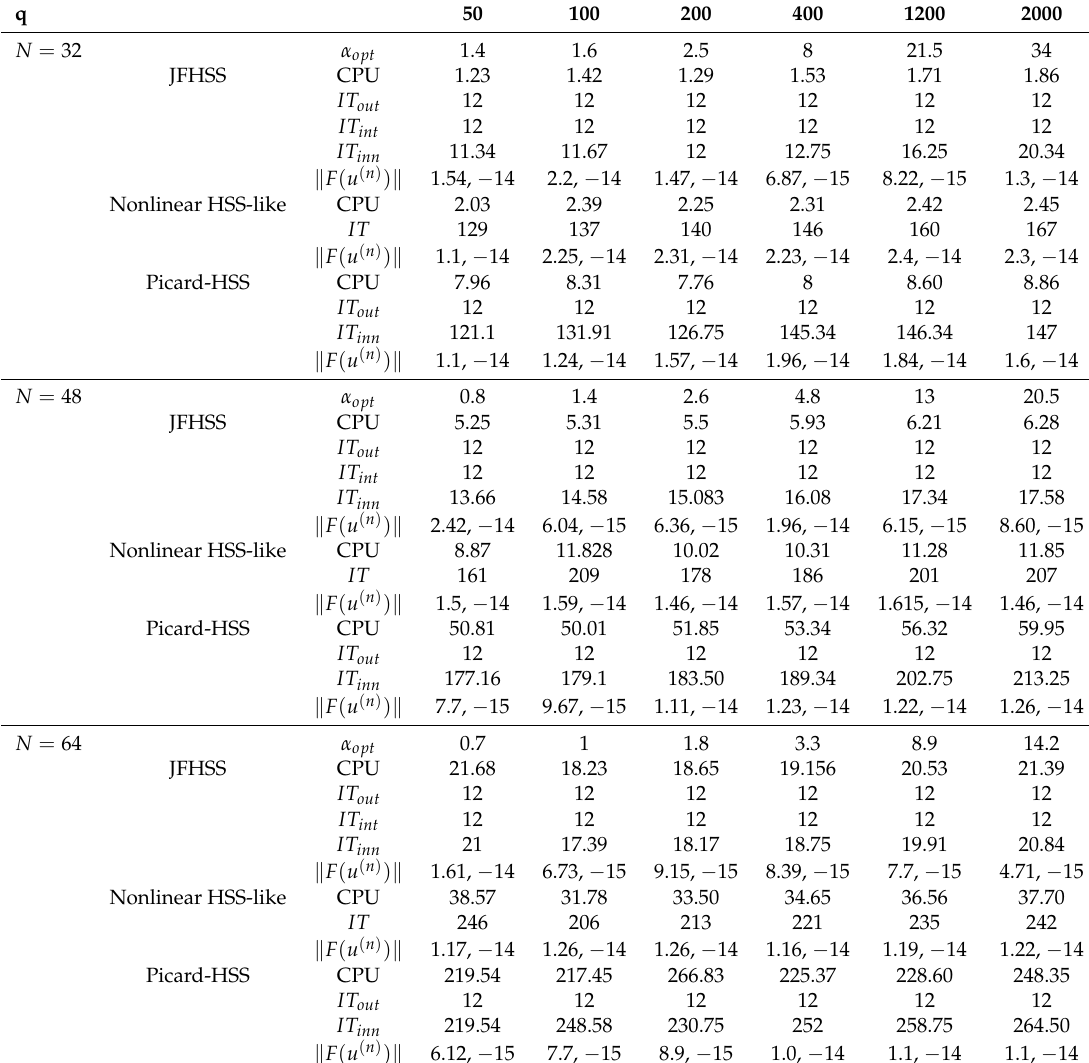
Table 4. Results of JFHSS, nonlinear HSS-like and Picard-HSS methods for Example 2 ( η = tol = 0.1). q N = 32